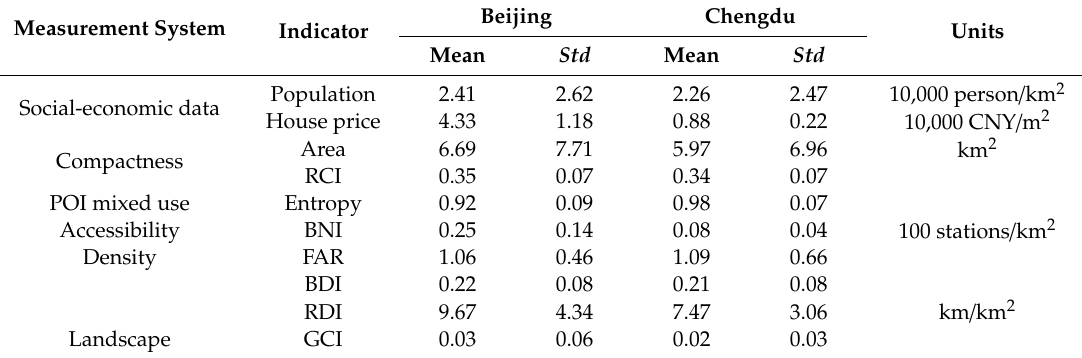
Table 1. Characteristics of built environment variables in regulatory planning management unit